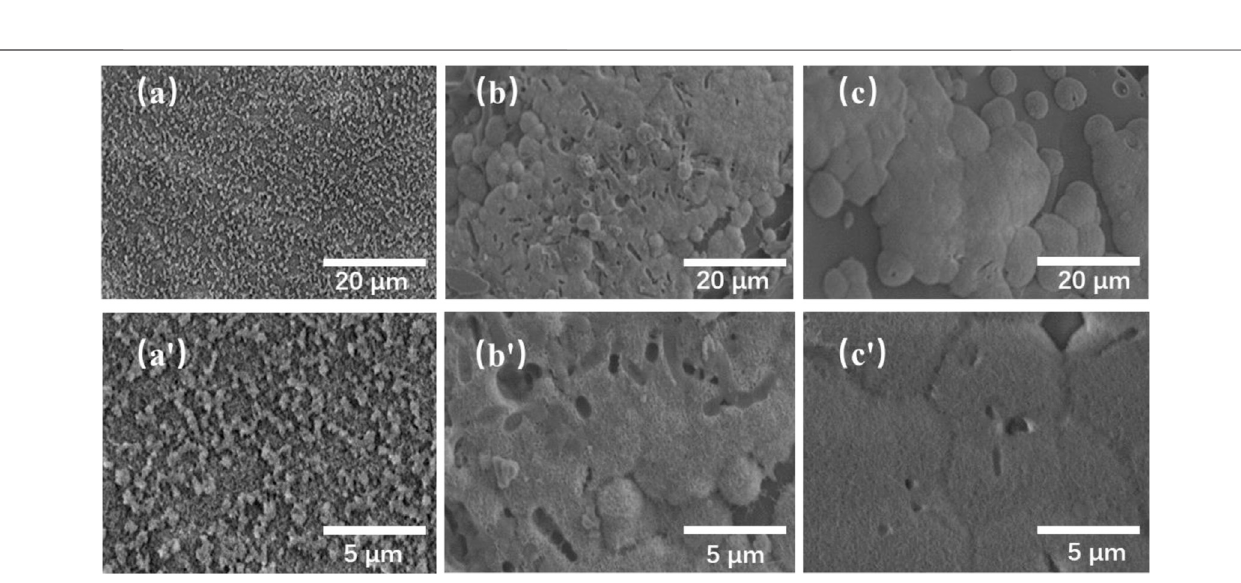
Frontiers in Materials |